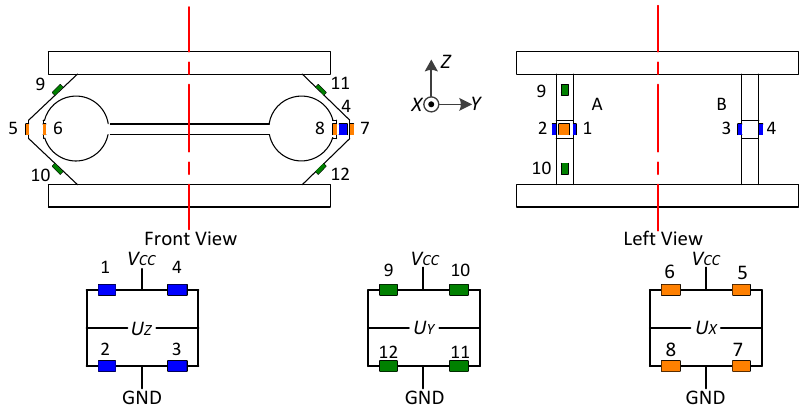
Figure A4. A diagram of the fixed force sensor.